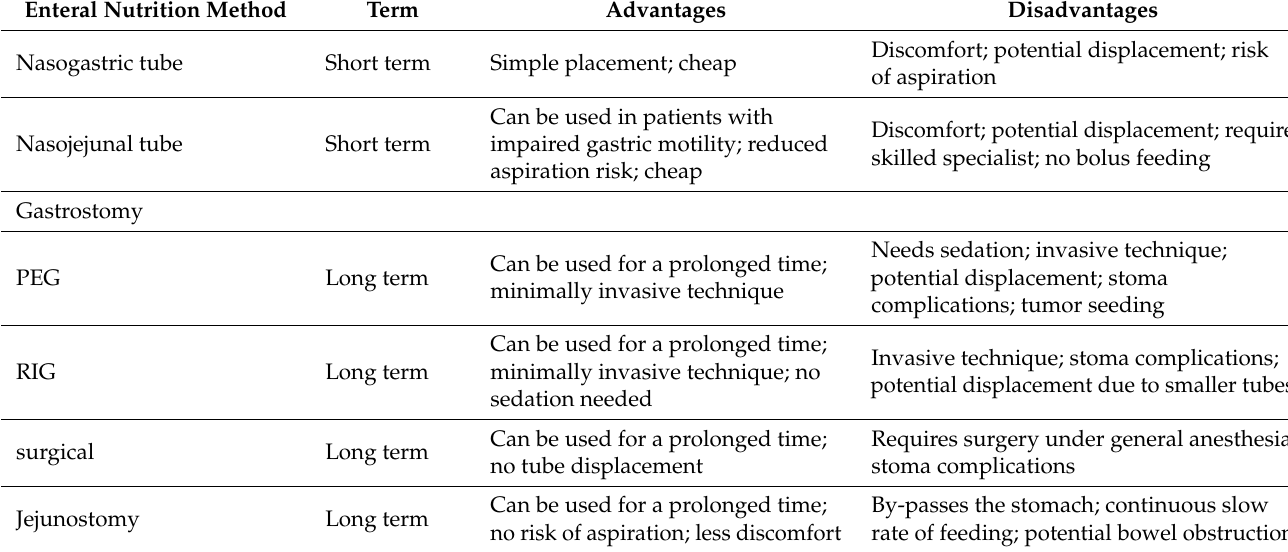
Table 2. Enteral nutrition modalities and their